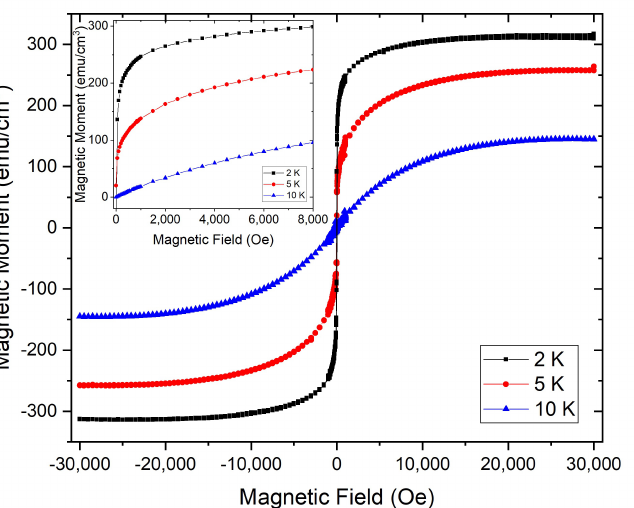
Figure 4. ZFC Isothermal magnetisation hysteresis loops of the Si/SiO 2 /graphene/Eu 3 O 4 /Au sample measured as a function of the applied in-plane magnetic field at 2 K, 5 K and 10 K. The inset highlights the virgin magnetisation curves at these